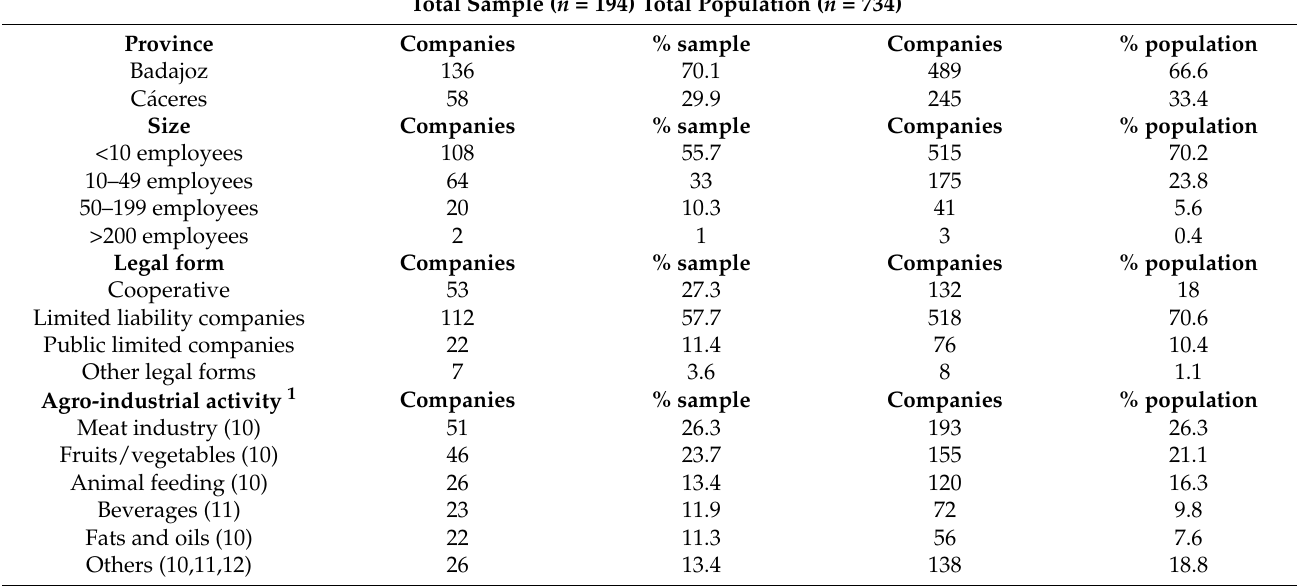
Table 1. General characteristics of the